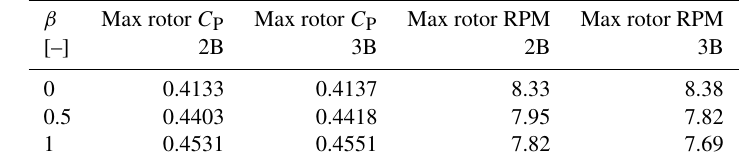
Table 2. Rotor design candidate summary.